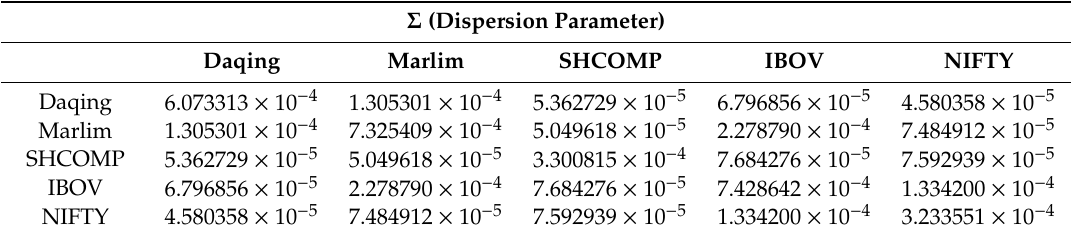
Table A11. MNIG Dispersion parameter Σ for Vector 3: Daqing, Marlim, SHCOMP, IBOV, NIFTY. Σ (Dispersion Parameter)